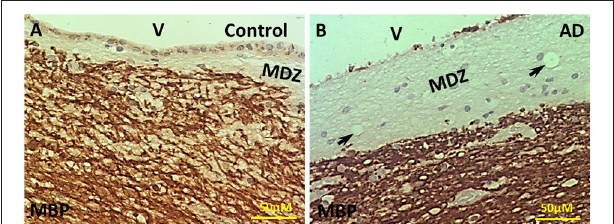
FIGURE 1 | Immunohistochemistry of MBP in the PVWM of AD and control brains. (A) Intact MBP immunostaining in the PVWM of control brain. A thin myelin-deficit zone (MDZ) was observed under the ependymal cells. Some ependymal cells were stained for Intact MBP. (B) Intact MBP staining in the PVWM of AD brain. The MDZ was much wider in AD brain. There was a loss of many ependymal cells. A few areas of no tissue staining were observed (arrows). Note: Dark Brown, positive staining; MBP, myelin basic protein; V, ventricle; MDZ, myelin-deficient zone; PVWM, periventricular white matter; AD, Alzheimer’s disease; Bar = 50 µ